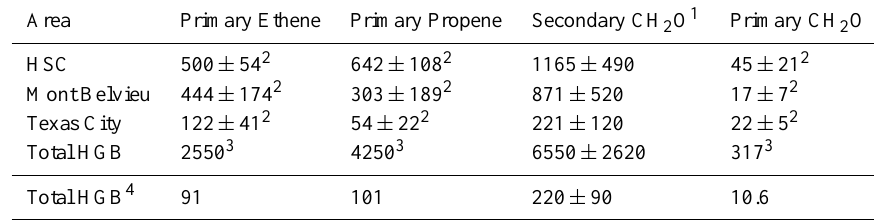
Table 1. Summary of the measured and inventory average primary emission fluxes and estimated secondary formation rate of CH 2 O from petrochemical facilities in the HGB given as 24-h averages. The indicated uncertainties are estimated 1- σ confidence limits. Units are kgh − 1 except as noted. Area Primary Ethene Primary